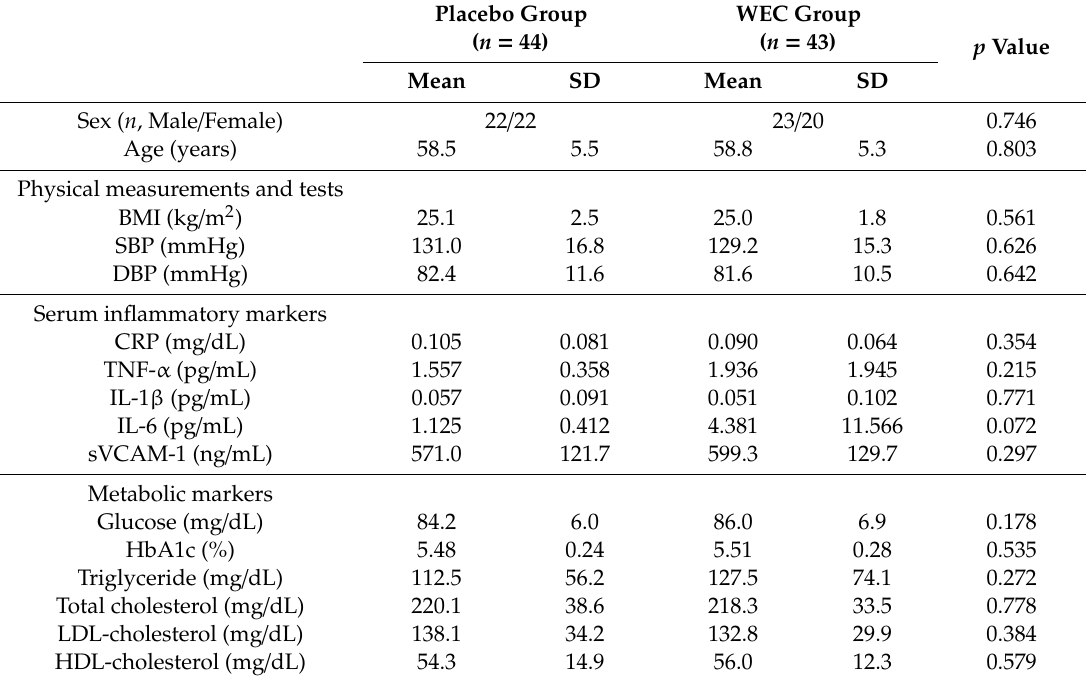
Table 2. Baseline characteristics of the subjects with potential inflammation 1